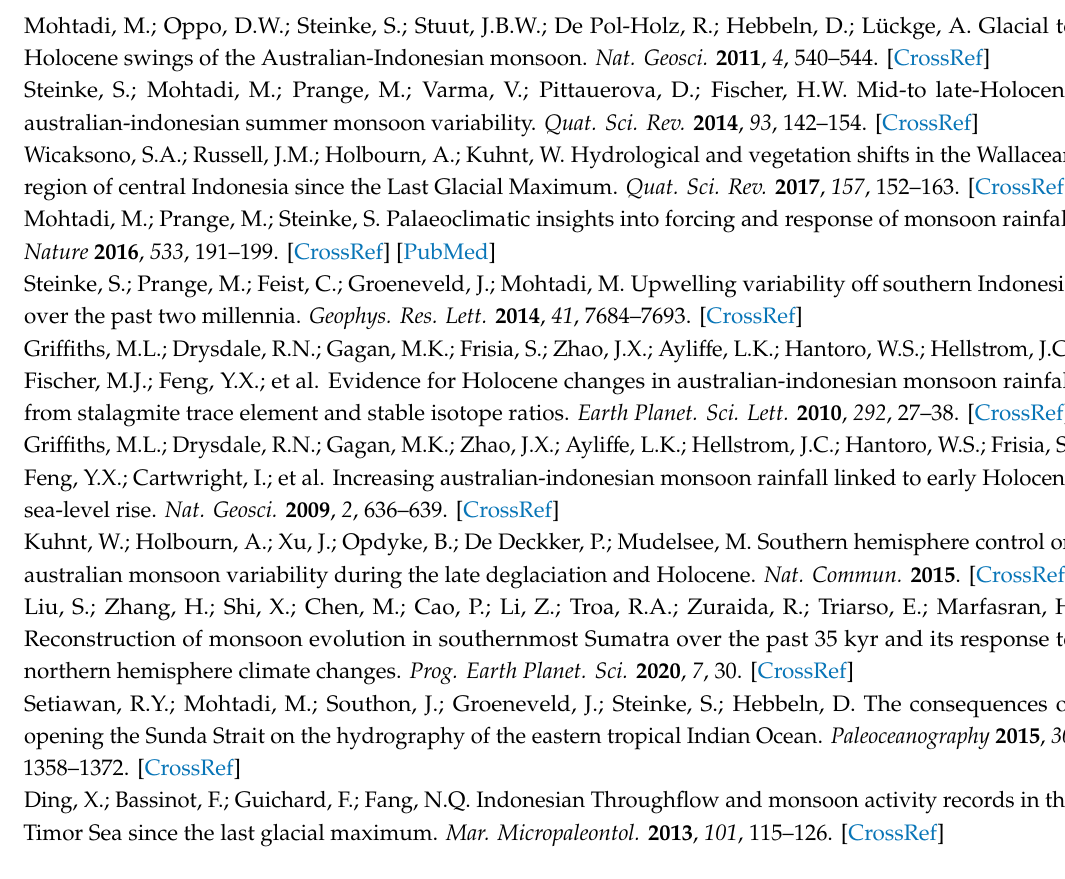
Table S1: Sedimentation rates, Table S2: ST08 total foraminifera and the abundance of Neogloboquadrina spp., Table S3: ST08 XRF-based geochemical element data, Table S4: ST08 palynological proxies (pollen and spores), Table S5: Smoothed values of paleoclimate records presented in Figures 7 and 8. The insolation, sunspot numbers, and paleoclimate data used for comparison in this study are available at https: // www.ncdc.noaa.gov / paleo-search / and https: // www.pangaea.de / . The bathymetry data from GEBCO Bathymetric Compilation Group 2020 are available at https: // www.gebco.net / data_and_products / gridded_bathymetry_data /